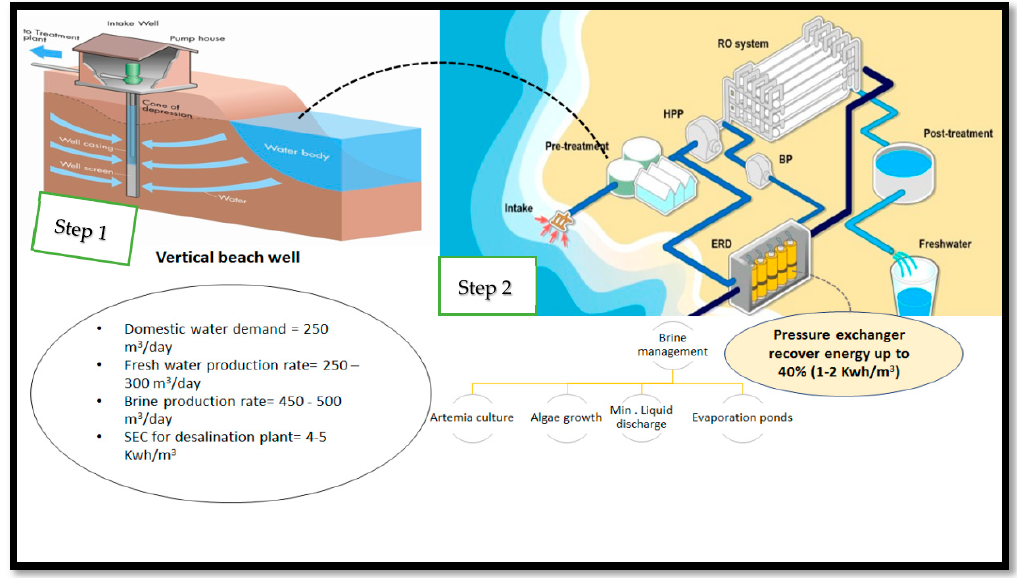
Figure 4. Integration system between vertical sand well filtration and desalination plant.